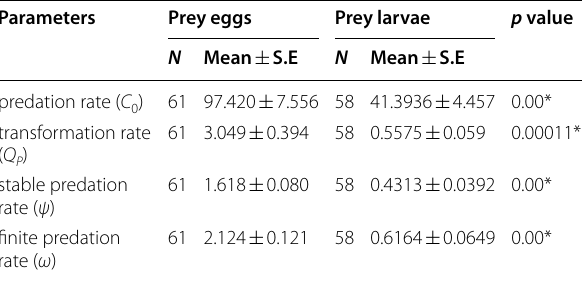
Standard errors were estimated by using 100,000 bootstraps. *Means followed by marked p values are significantly different between two treatments using the paired bootstrap test at the 5% significance